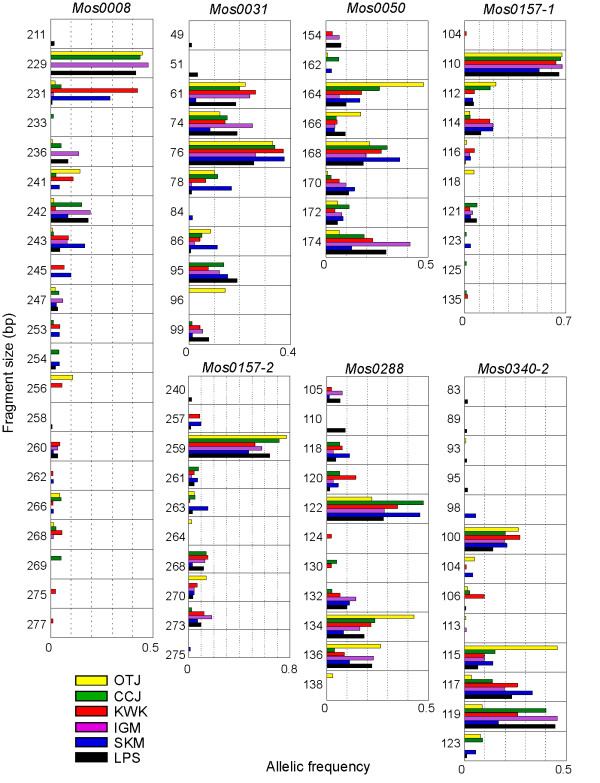
The distribution of alleles of each population for the seven microsatellite loci.